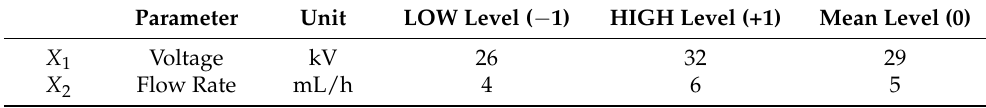
Table 2. Inputs ( Xs )—the two selected materials and processing parameters in this investigation.